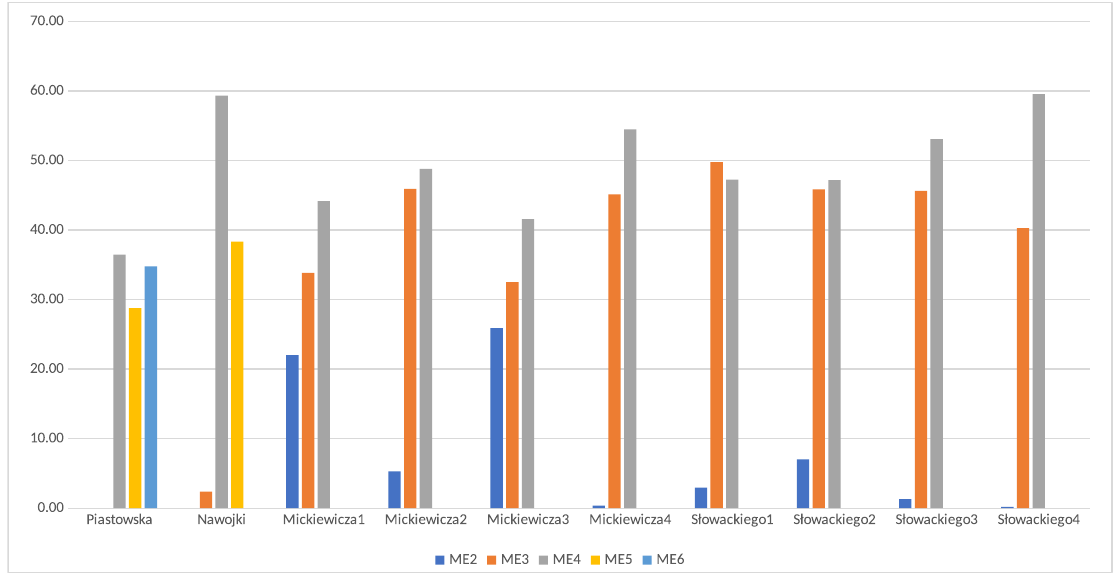
Figure 6. Dynamic control lighting class participation on particular